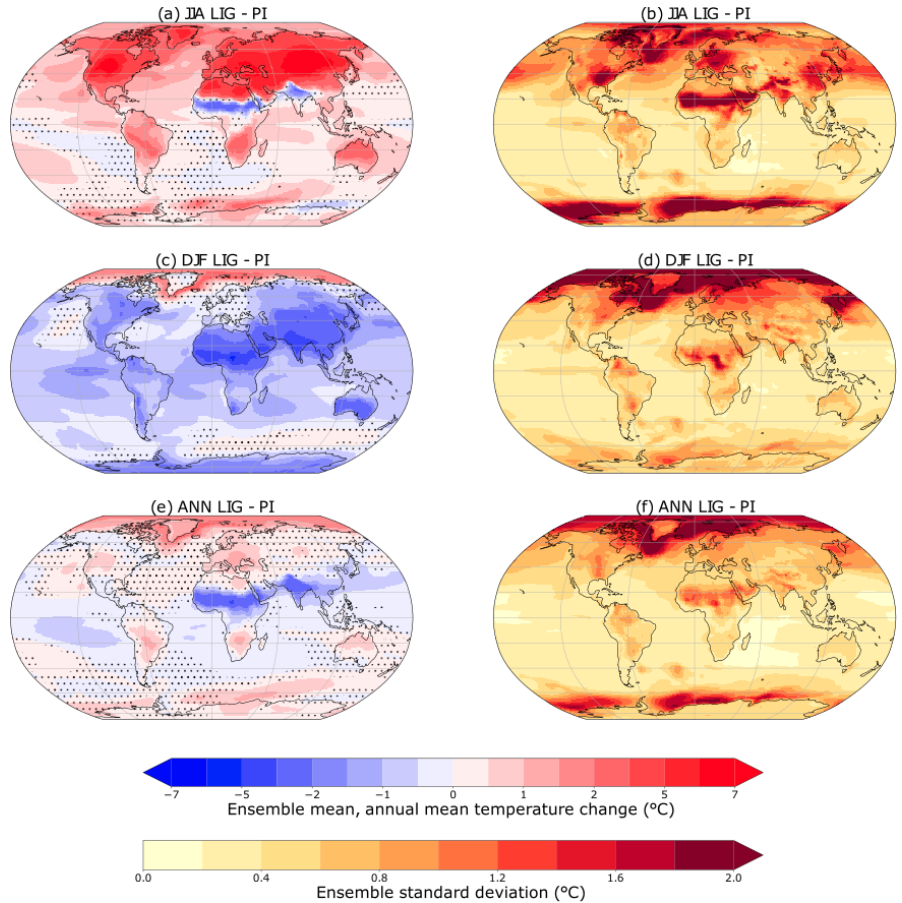
Figure 5. Multi-model ensemble average changes (a, c, e) and across-ensemble standard deviations (b, d, f) of surface air temperatures ( ◦ C) for lig127k minus piControl . Shown are June–July–August (a, b) , December–January–February (c, d) , and annual mean (e, f) changes. Dots indicate where less than 12 (70%) of the 17 models agree on the sign of the